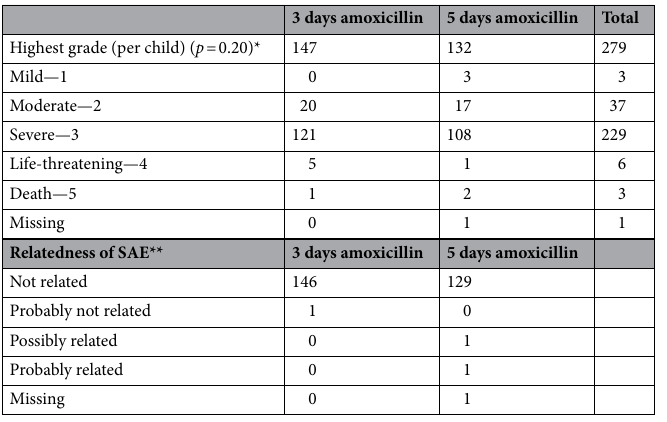
3 days amoxicillin 5 days amoxicillin Total Highest grade (per child) ( p =